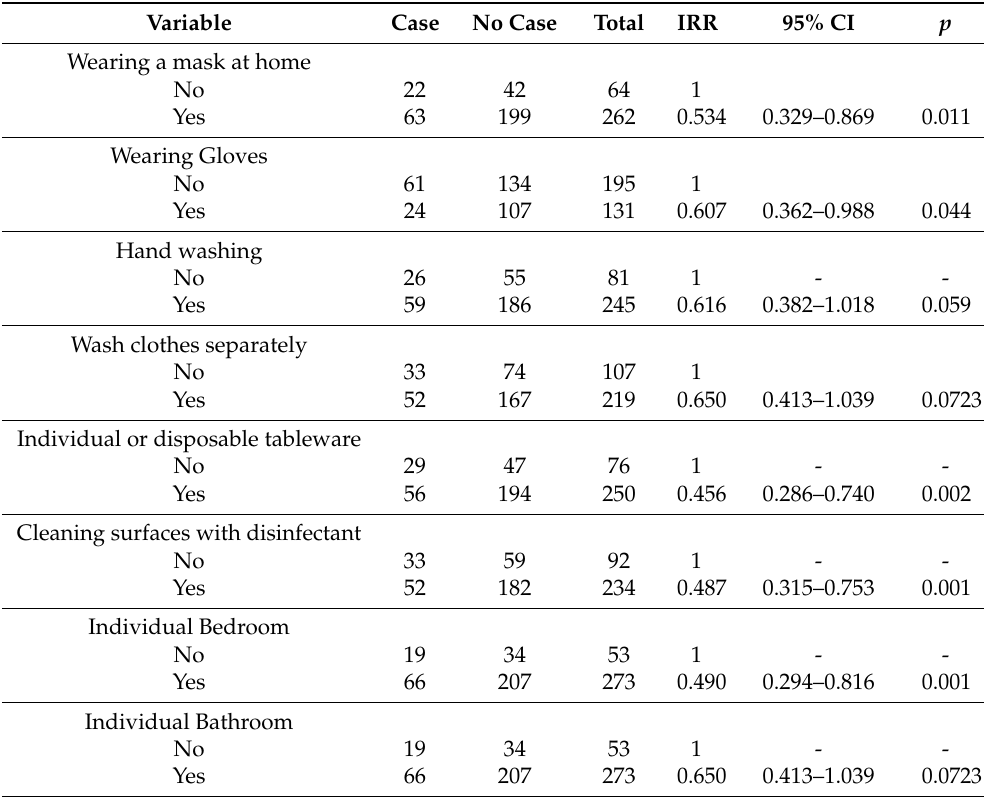
Table 4. Univariate Exact Poisson regression of secondary transmission according to preventive measures taken by health workers to prevent infection at home.